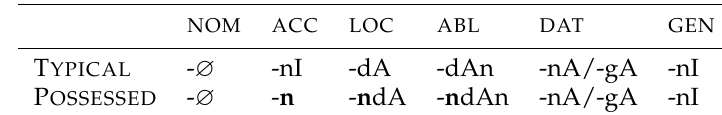
tepse-si-*(n)de chair-3 POSS - LOC